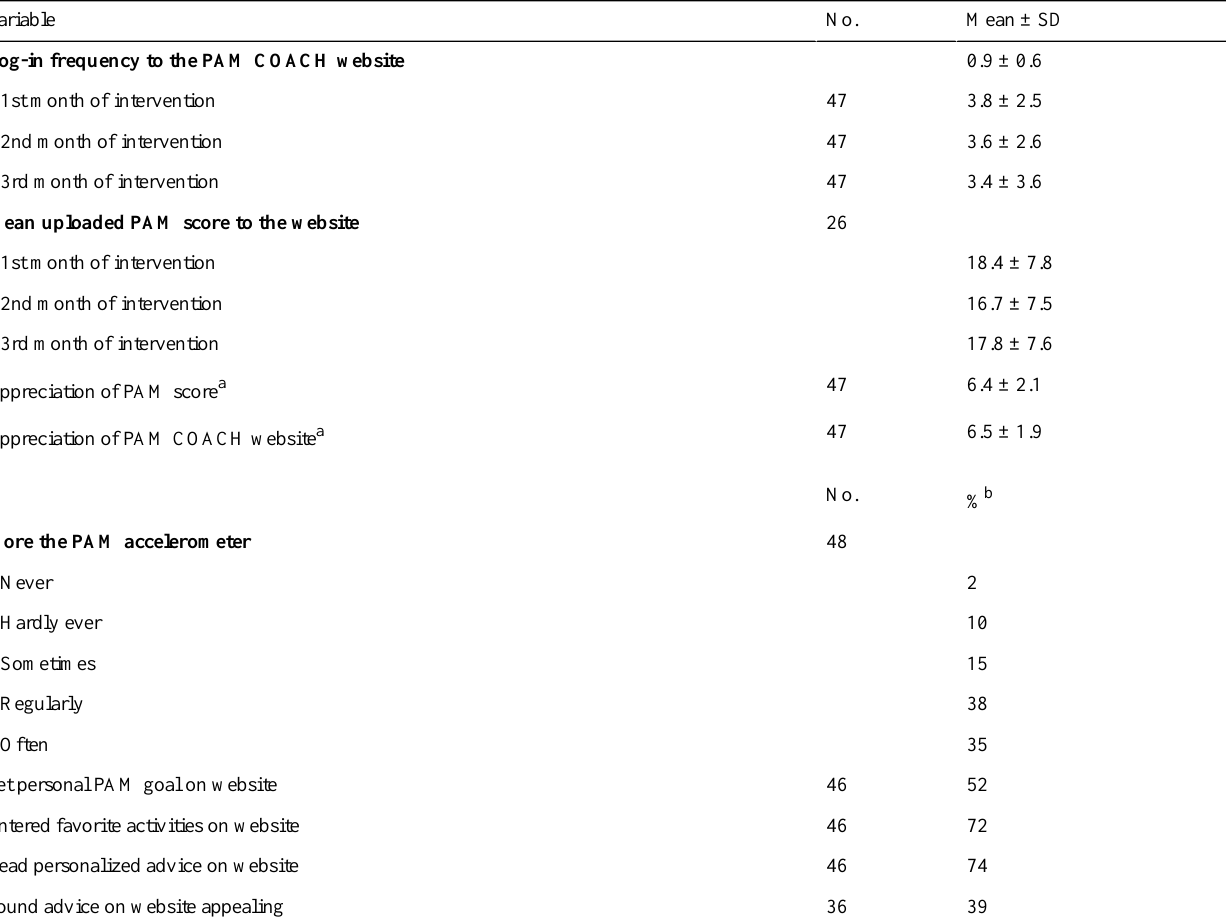
Table 5. Process evaluation data of the PAM accelerometer and the PAM COACH